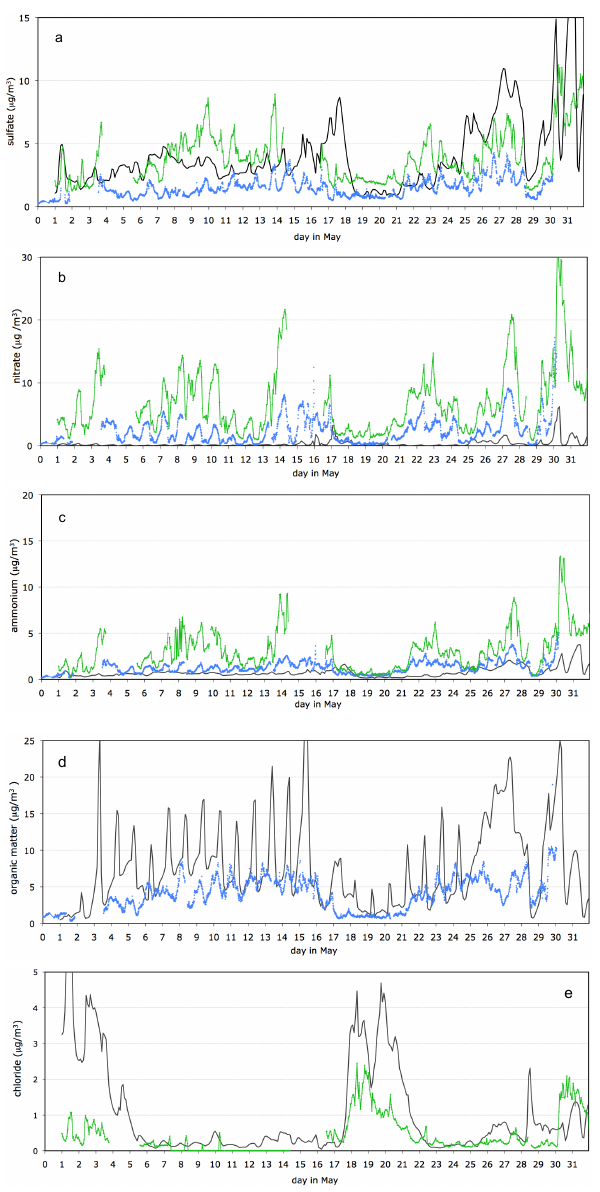
Fig. 6. Observed (blue) and simulated (black) concentration profiles Figure 6. Observed (blue) and simulated (black) concentration profiles (cm -3 ) (cm − 3 ) averaged over 2–14 May (daytime) for (a) the Aitken mode Fig. 5. Observed (blue, green) and simulated (black) concentrations averaged over May 2-14 (daytime) for a) the Aitken mode (size range observations: (size range observations: 10–150nm diameter; model: 5–50nm ra- (µg/m 3 ) of (a) sulfate, (b) nitrate, (c) ammonium, (d) organics and dius), (b) the accumulation mode (size range observations: 150– 10-150 nm diameter; model: 5-50 nm radius), b) the accumulation mode (size range (e) chloride. Observations are from IMPACT, and simulation results 1000nm diameter; model: 50–500nm radius), and (c) the coarse pertain to the Cabauw grid point. Measurements in blue are from observations: 150-1000 nm diameter; model: 50-500 nm radius), and c) the coarse mode (size range observations: 1–3µm diameter; model: > 0.5µm ICG-2 J¨ulich (Germany) and reflect particle sizes < 0.56µm diam- mode (size range observations: 1-3 µ m diameter; model: > 0.5 µ m radius). Dashed radius). Dashed lines reflect the simulated standard eter. Measurements in green are from ECN (The Netherlands) and lines reflect the simulated standard deviation. reflect total aerosol mass.